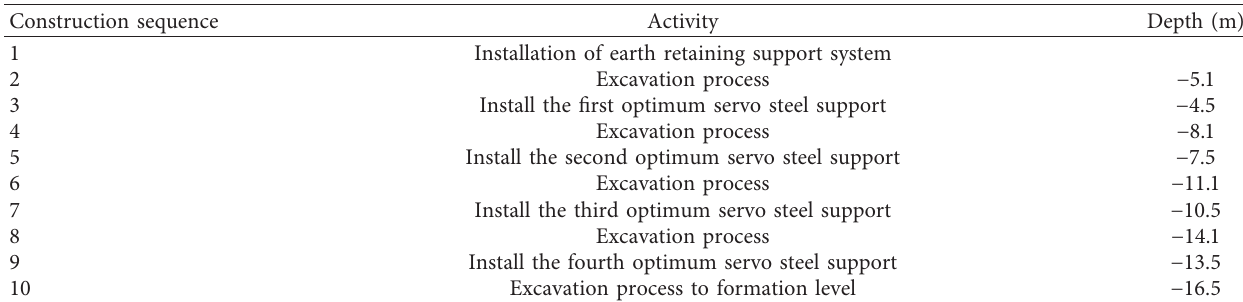
Figure 15: Shenzhen Line 12 subway station excavation pit profile showing cross-sectional view through Guangzhou-Dongguan-Shenzhen intercity railway section intersection. Table 5: Subway station field excavation